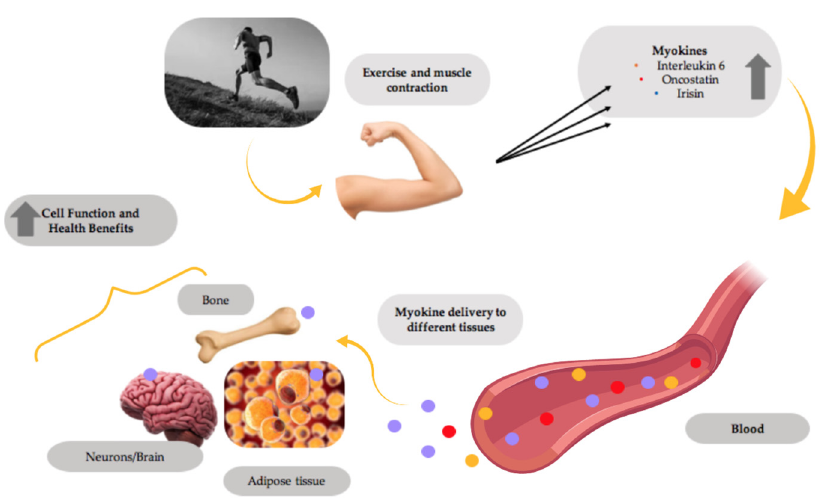
Figure 1. Myokines mediate the health benefits of exercise. Muscle contractions induce the production and release of myokines by muscle, which are delivered through the blood circulation to different tissues in the body, improving the overall tissue function and providing health benefits. This figure was created with BioRender.com.